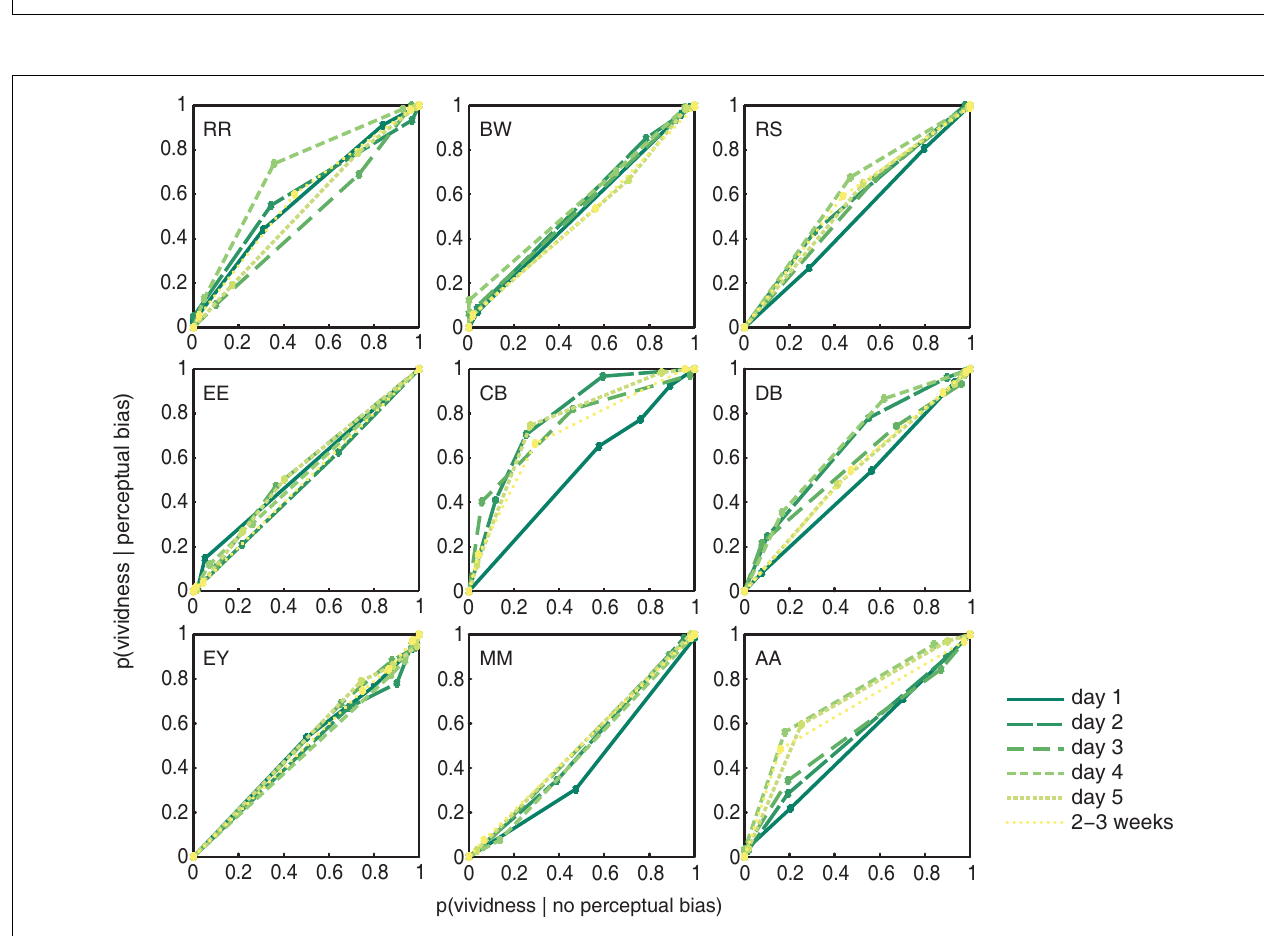
FIGURE 3 | Mean percentage of catch trials on which participant’s response to the fake-rivalry display was biased in favor of the imagined grating. A score of 50% indicates a lack of bias. Gray shaded areas show each individual participant, the colored bars represent the 5days of training plus follow-up 2–3weeks later.